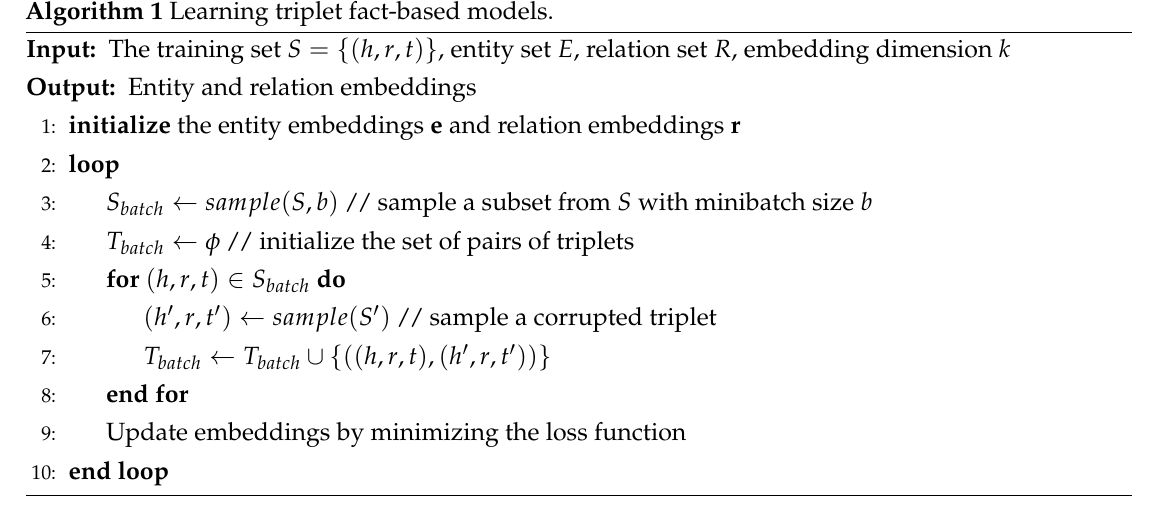
Algorithm 1 Learning triplet fact-based